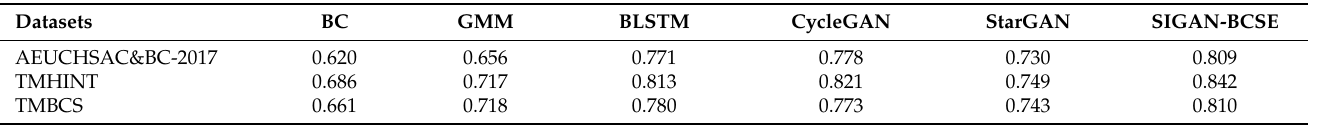
Table 4. STOI evaluation of the enhanced BC speech obtained by different methods (double-ended indicators).